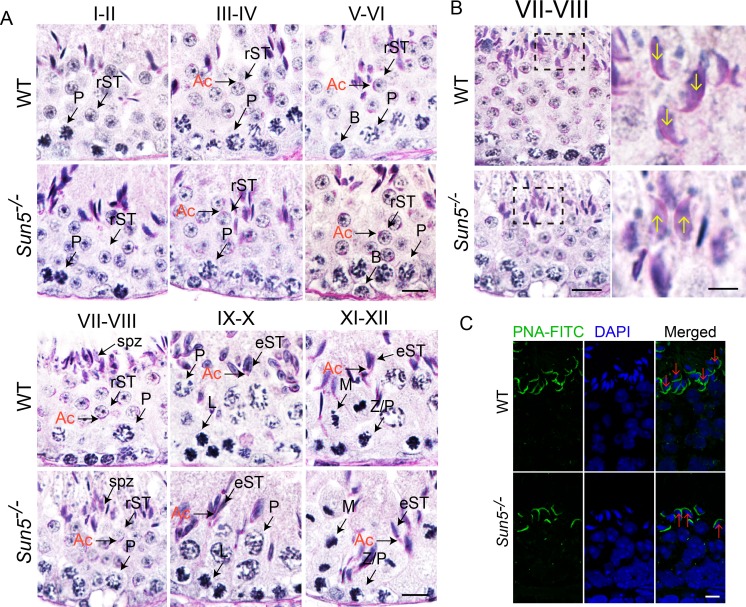
Spermiation defects in Sun5−/− mice.(A) Periodic acid-Schiff (PAS) staining revealed histology of all twelve developmental stages in WT and Sun5−/− testes. The morphology of Acrosome (Ac) marks the specific developmental stages. Scale bar, 10 μm. (B) Sun5-null spermatids have lost their orientation toward the basement membrane during spermiation in stage VII-VIII seminiferous epithelia. The arrows indicate the orientation of the sperm heads. Scale bar: left panel, 10 μm; right panel, 5 μm. (C) Peanut agglutinin (PNA) staining of stage VII-VIII seminiferous epithelia showed the miss-arranged spermatids in Sun5−/− testes. The arrows indicate the orientation of the sperm heads. Scale bar, 5 μm. Ac: acrosome; B: B type spermatogonium; eST: elongating spermatid; L: leptotene spermatocyte; M: meiotic spermatocyte; P: pachytene spermatocyte; rST: round spermatid; spz: spermatozoon; Z: zygotene spermatocyte.